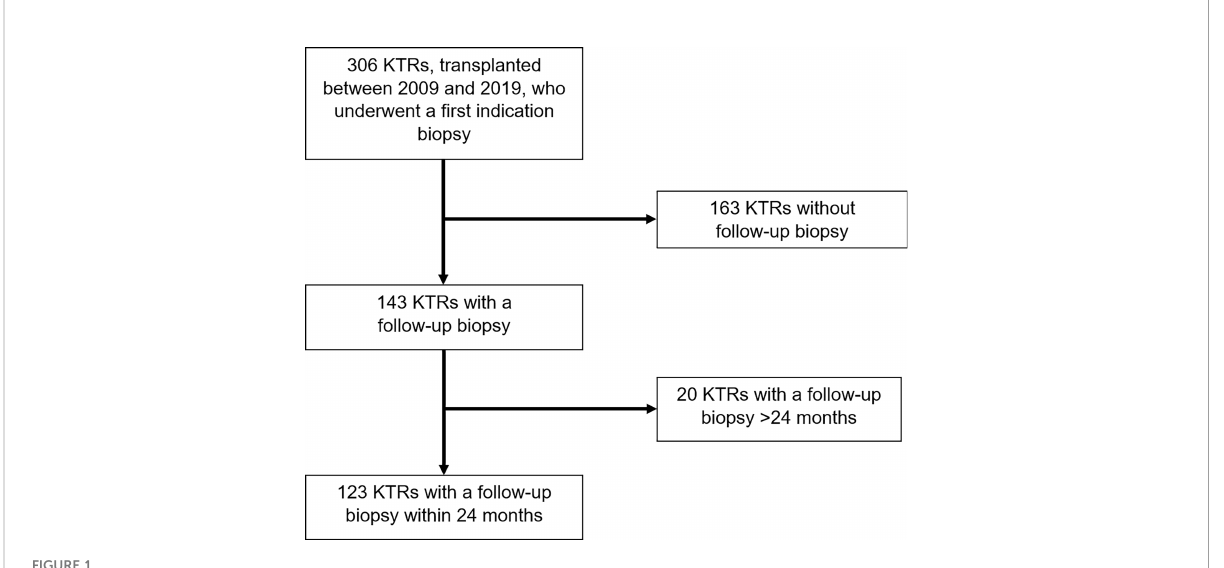
FIGURE 1 Patient inclusion and exclusion